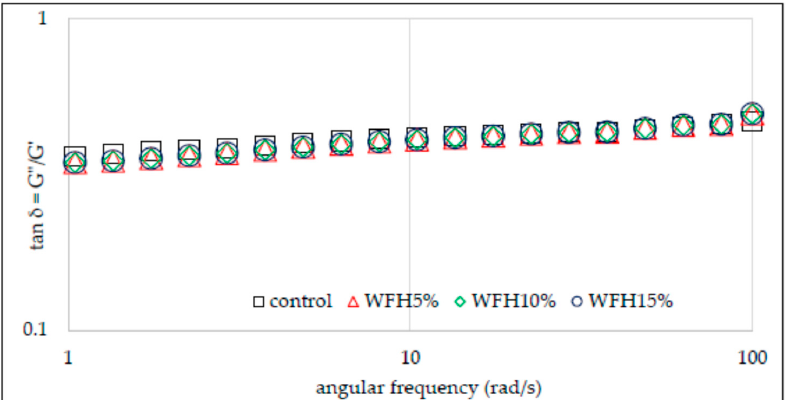
Figure 5. Tangent δ depending on the angular frequency of wheat flour gel and samples with hazelnuts addition.